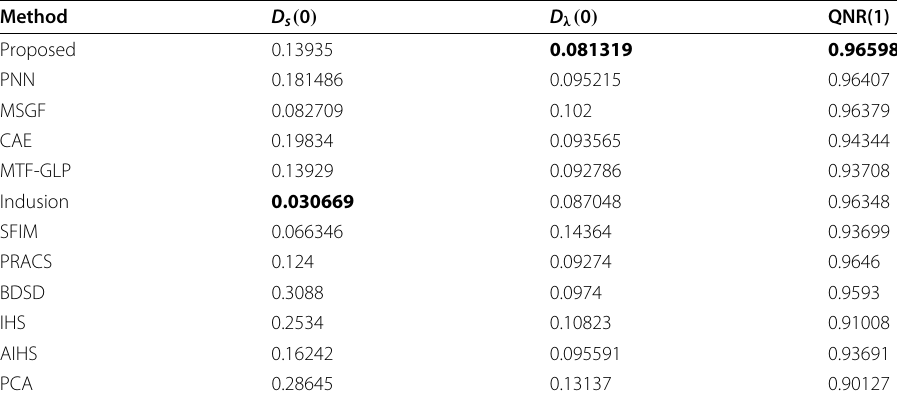
Table 6 Numerical results of the real QuickBird-2